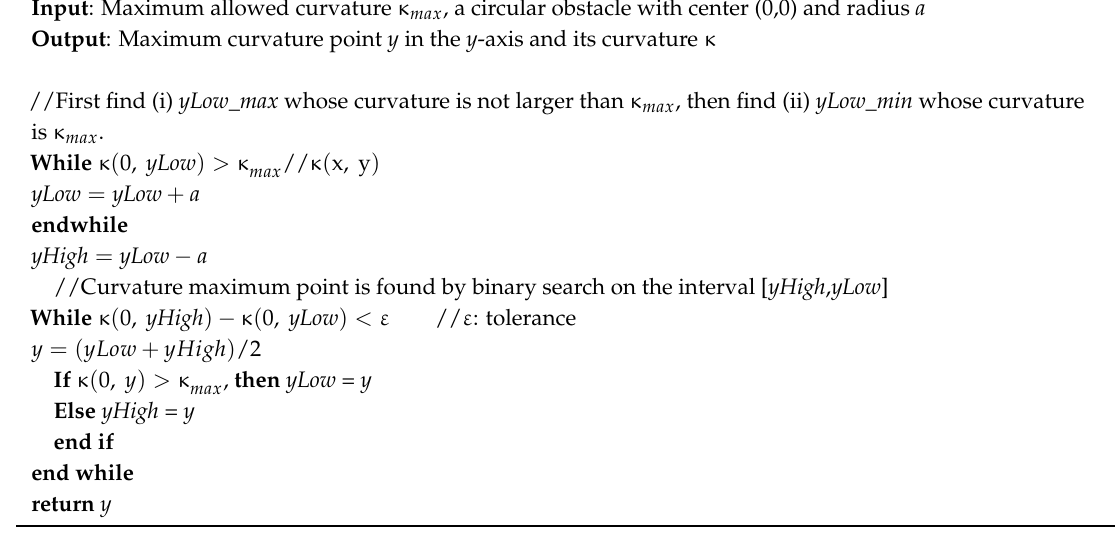
Algorithm 1. Bisection for searching yLow_max , yLow_min